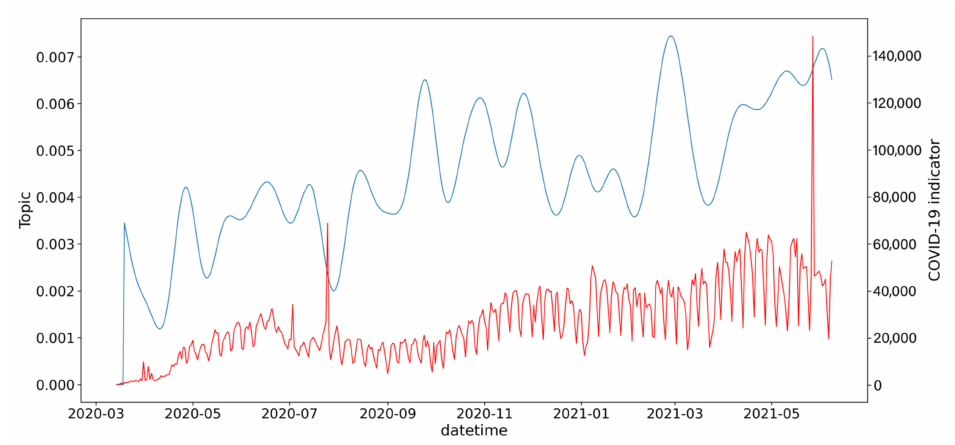
Figure A4. COVID-19 indicator—New tests. Topic—Kazinform, Interesting, Mia, Mia_kazinform, Correspondent_mia, Correspondent_mia_kazinform, Transmit.